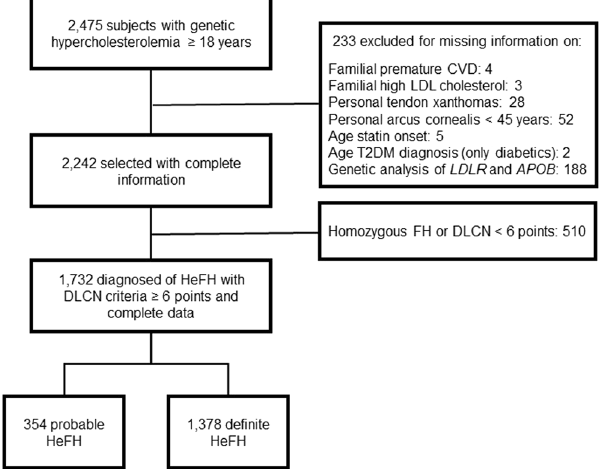
Figure 1. Study flow diagram. HeFH, heterozygous familial hypercholesterolemia; HoFH, homozygous familial hypercholesterolemia; DLCN, Dutch Lipid Clinic Network.